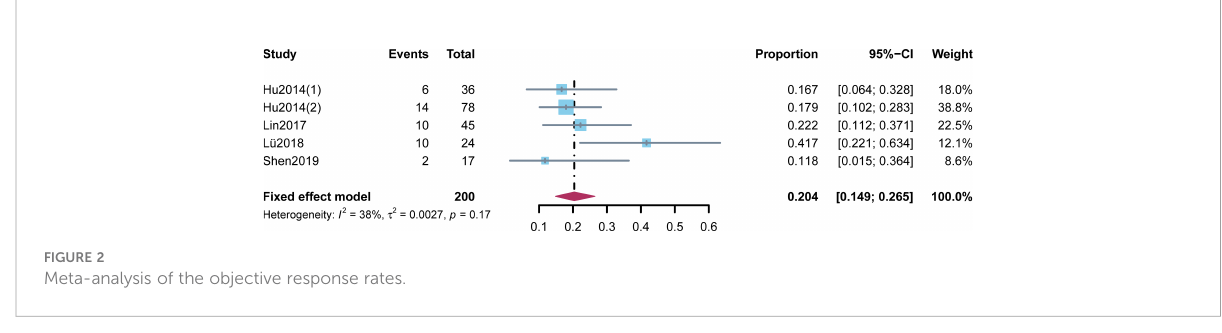
FIGURE 2 Meta-analysis of the objective response rates.